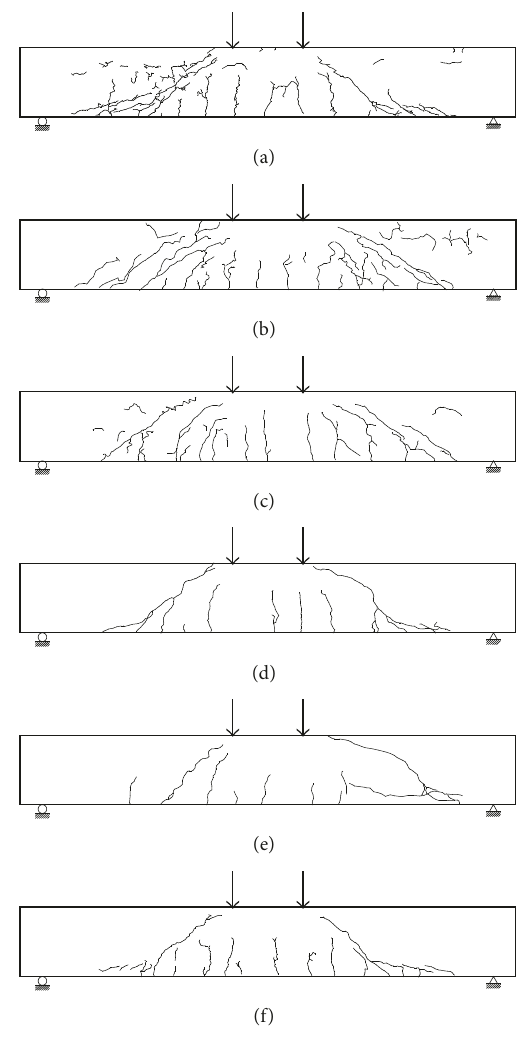
Figure 7: Crack pattern of shear test specimens (a) S25-0.5d, (b) S22-0.5d, (c) S19-0.5d, (d) S25-0, (e) S22-0, and (f) S19-0. Table 6: Comparison of shear strengths from test and design